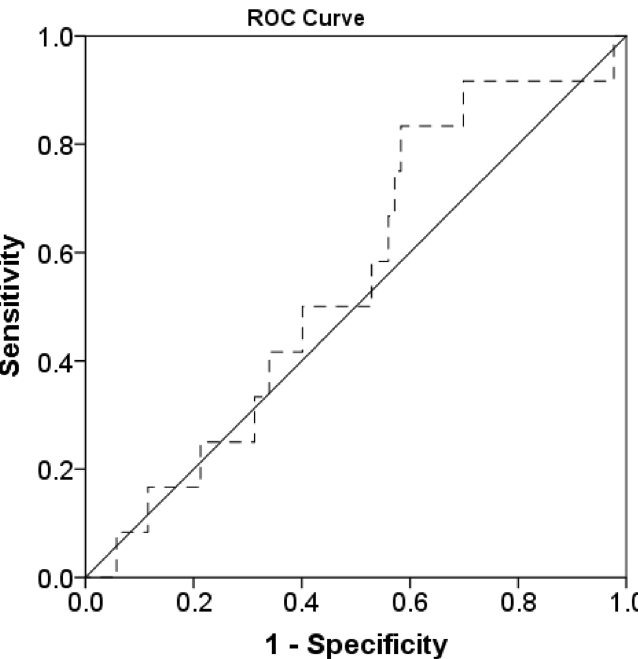
Figure 2. ROC curve analysis revealed PMI correlation with one year mortality after a living donor liver transplant for female PMI and 1-year mortality (sensitivity = 83.3%, specificity = 41.7%, AUE =